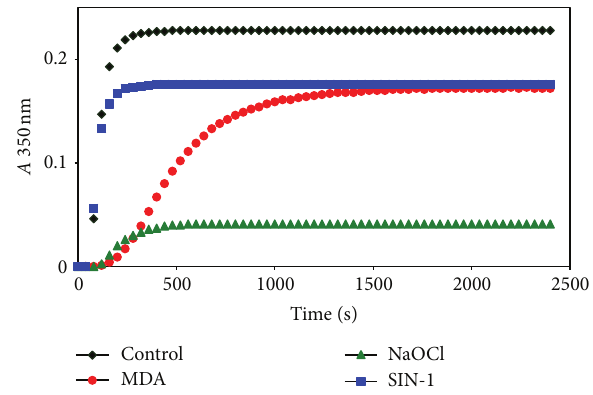
Figure 2: Representative curves of thrombin-catalyzed fibrin poly- merization. Fibrin clot formation from modified (modification times: MDA 30min, NaOCl 5min, and SIN-1 30min) or control fibrinogen (1mg/mL) was monitored at 350 nm after the addition of thrombin